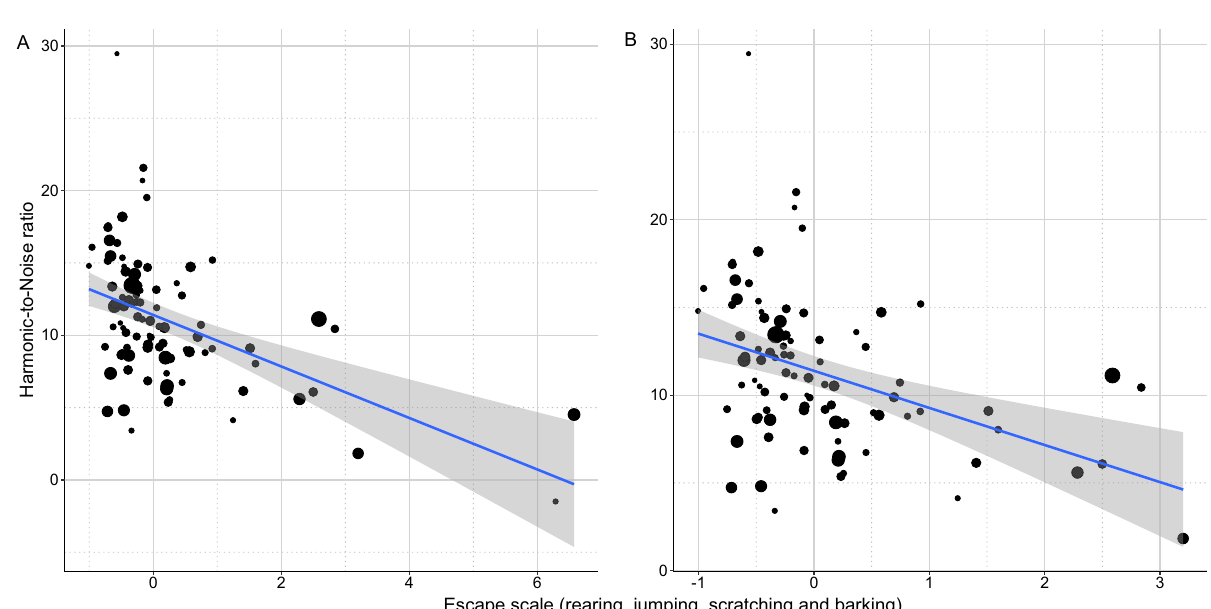
In the case of the chair/move scale (PC1) we found a positive association with wiener entropy (LM: β = 0.283; t = 3.11; p = 0.002; Fig. 7A,B): more active dogs spent more time orienting to and exploring the chair where the owner sat, and produced whines with a wider spectrum (higher entropy). Dogs that barked and tried to escape from the lab more (higher PC2 scores) during the separation had lower HNR, and thus noisier whines compared to dogs with fewer escape attempts (LM: β = − 1.657; t = − 4.969; p < 0.001; Fig. 8A,B).